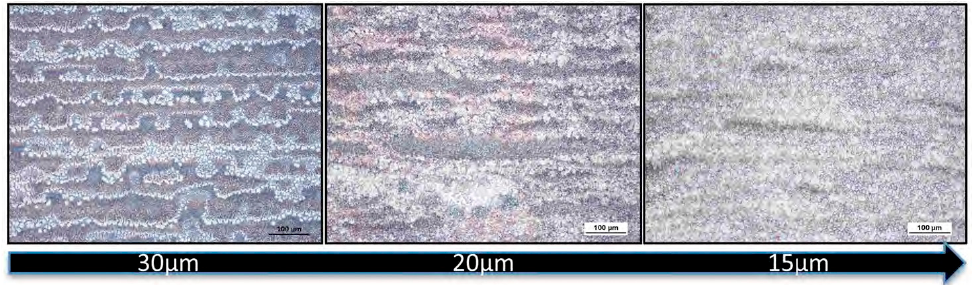
Figure 6. The 10MAPbI 3 -5S samples printed at 100 °C by using a drop spacing of 30, 20, and 15 μ m.